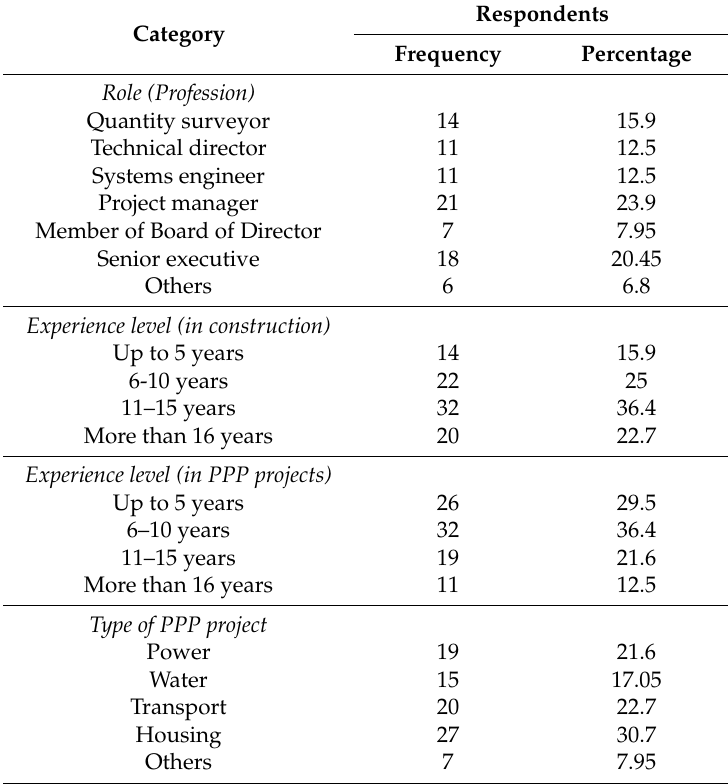
Table 1. Background information of the respondents.